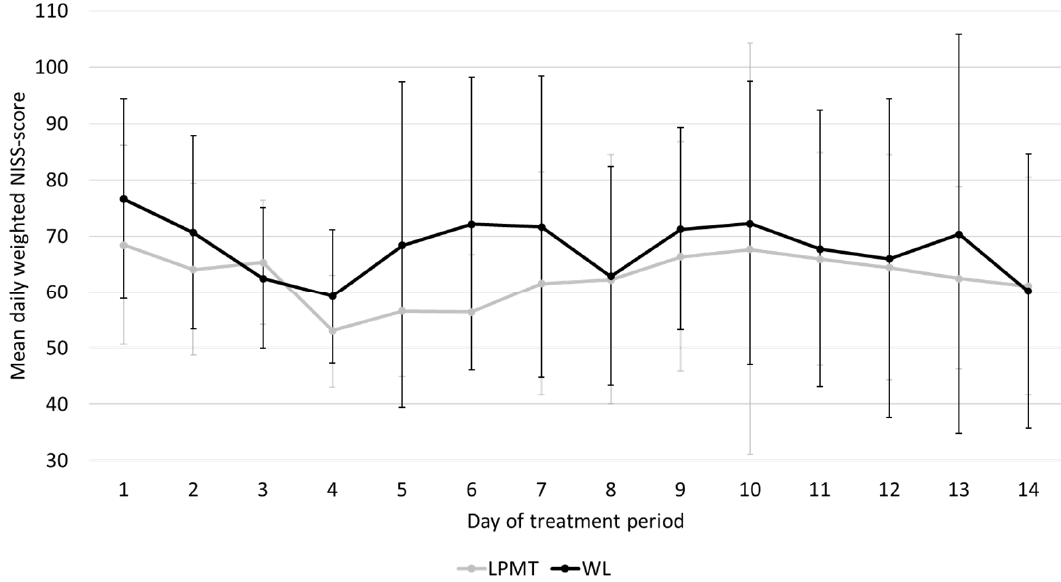
Figure 5. Course of mean daily NISS scores over the LPMT or waitlist periods. LPMT—live-performed music therapy; WL—waitlist.